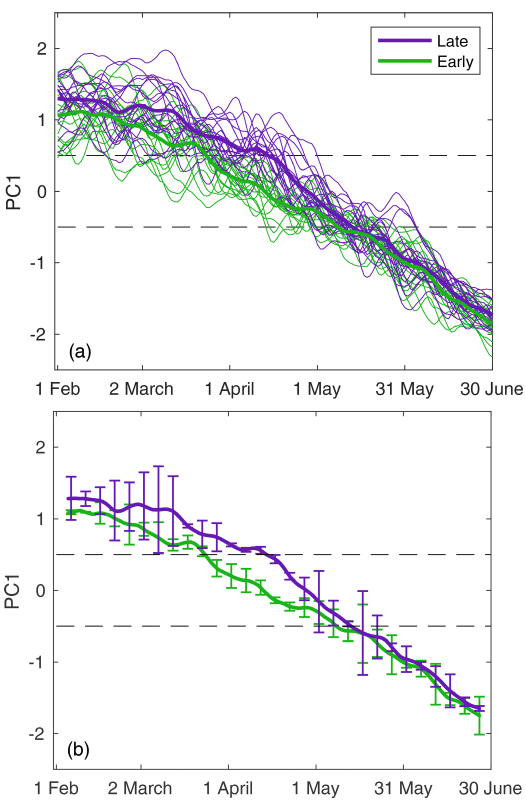
Figure 3. (a) The thick green and purple lines show the composite PC1 evolution and the thin green and purple lines show each year’s PC1 evolution, during 18 early and 19 late transition years, respec- tively. Panel (b) shows confidence intervals for the composite PC1 values for the early (green) and late (purple) groups. The dashed lines show the ± 0 . 5 σ